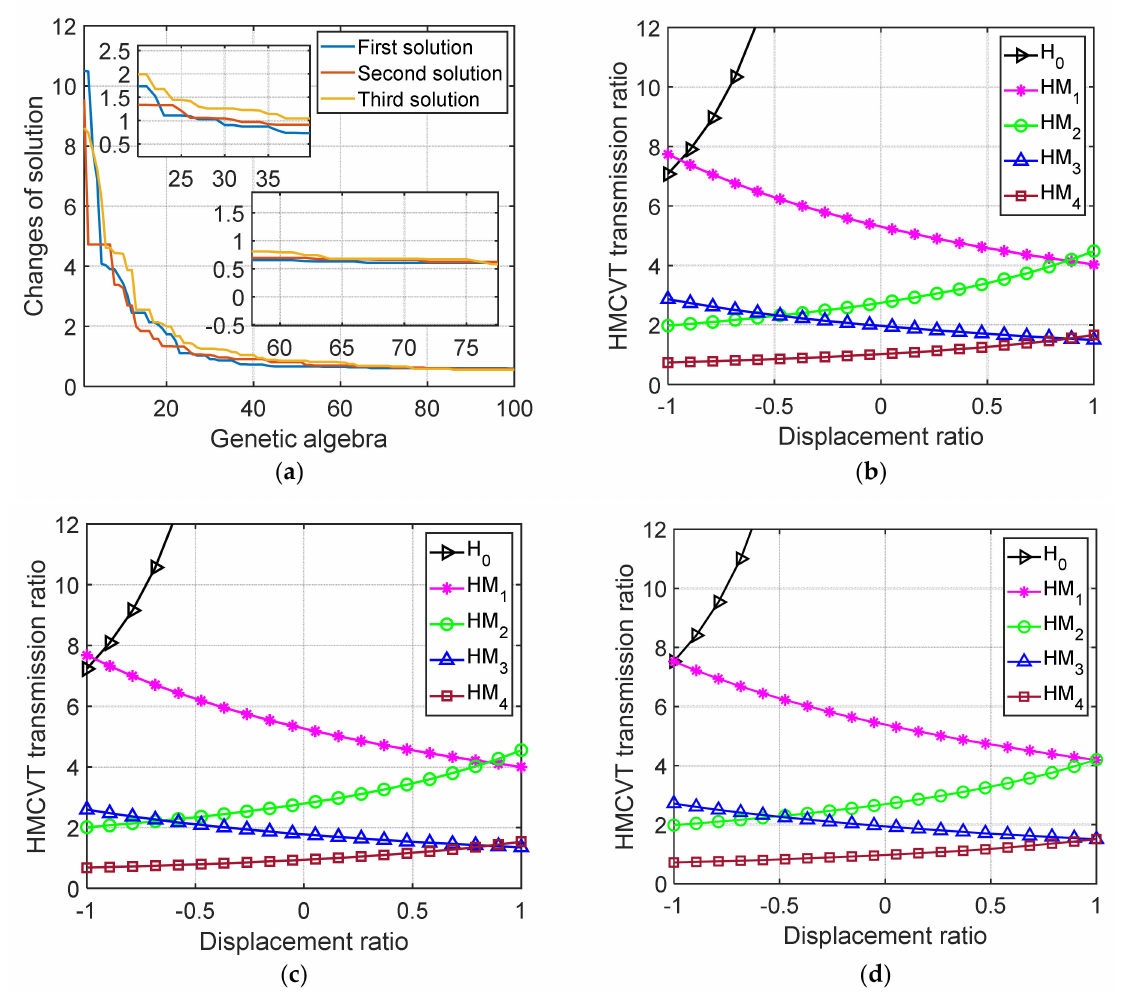
Figure 7. Optimization results of the proposed method. ( a ) Iterative evolution curve; ( b ) characteris- tics obtained by the first solution; ( c ) characteristics obtained by the second solution; ( d ) characteristics obtained by the third